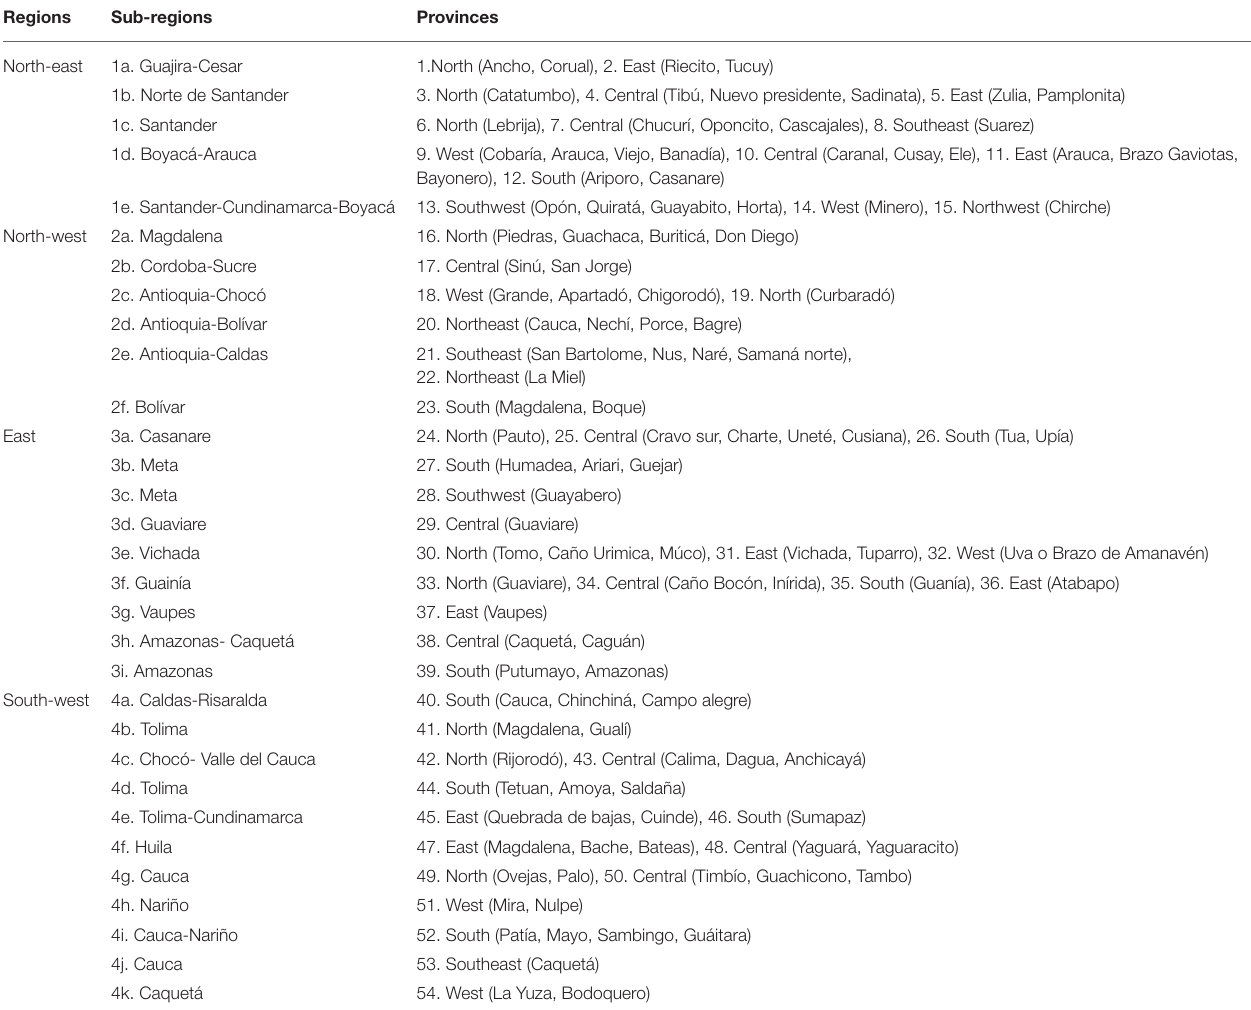
Provinces numbers correspond to the numbered panels in Figure 3